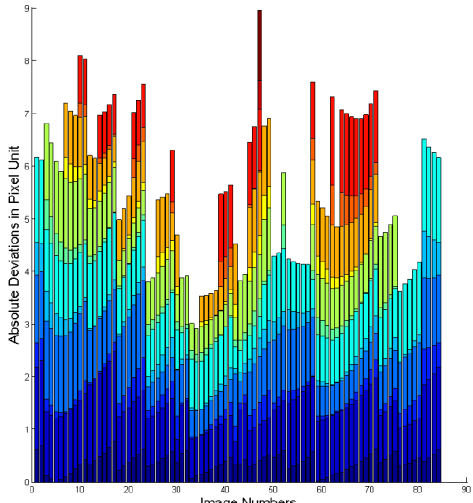
Figure 9. Absolute deviations of the re-projected estimated TLS data and estimated image targets in pixel unit - MI based approach